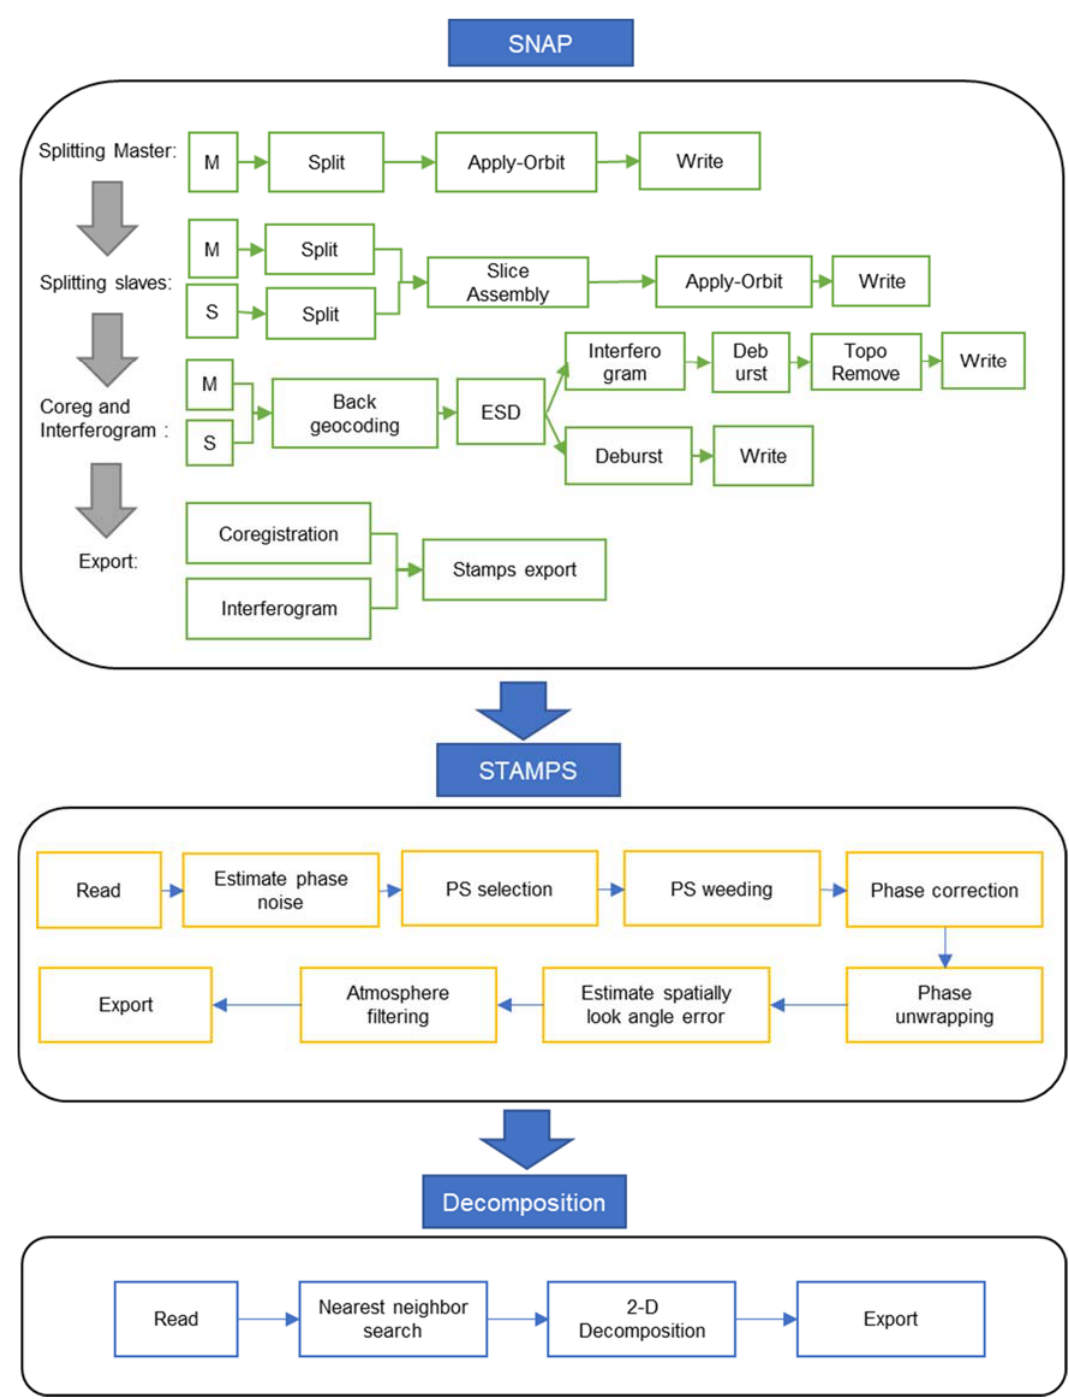
Figure 3. Workflow chart of InSAR.